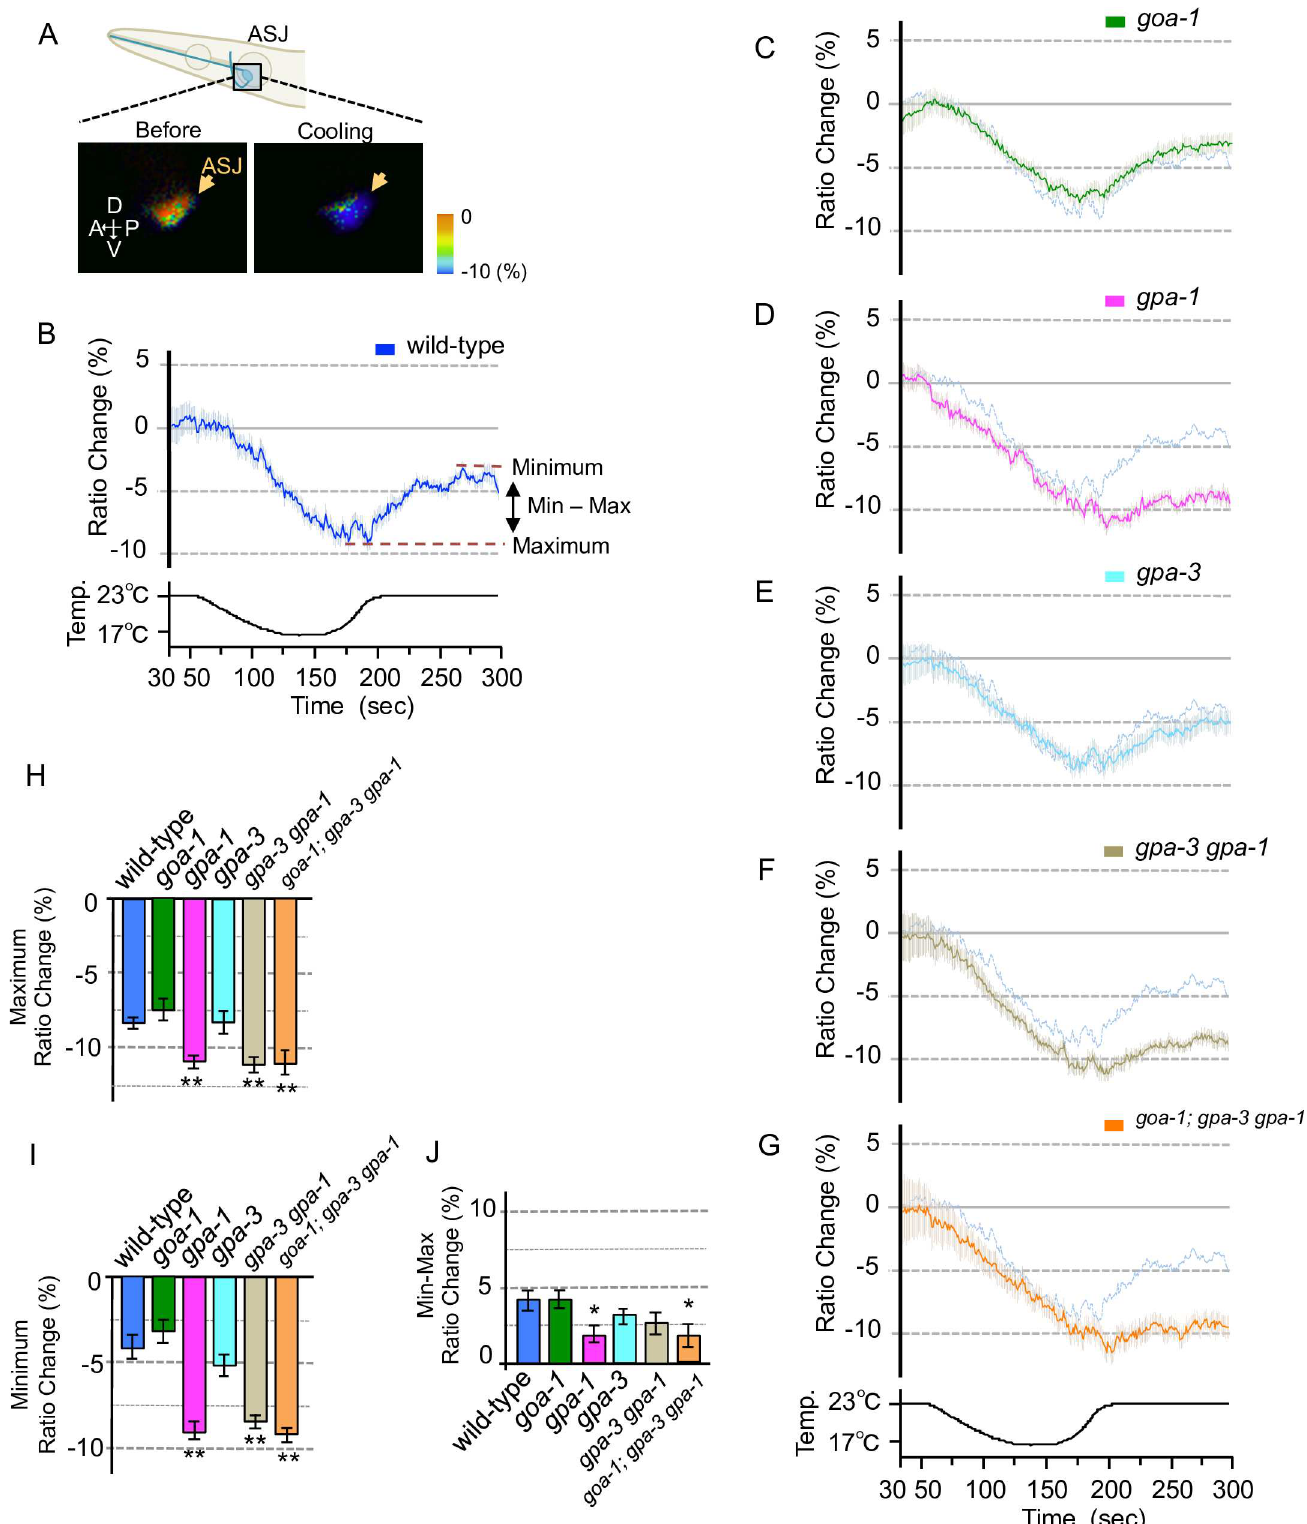
Fig 4. Calcium concentration changes in ASJ of G α mutants with cooling stimuli. ASJ specifically expressing YC3.60 in wild-type worms and G α mutants. (A) The schematic diagram indicatesan ASJ sensory neuron in the head. The bottom panel shows the response to cooling stimuli of the